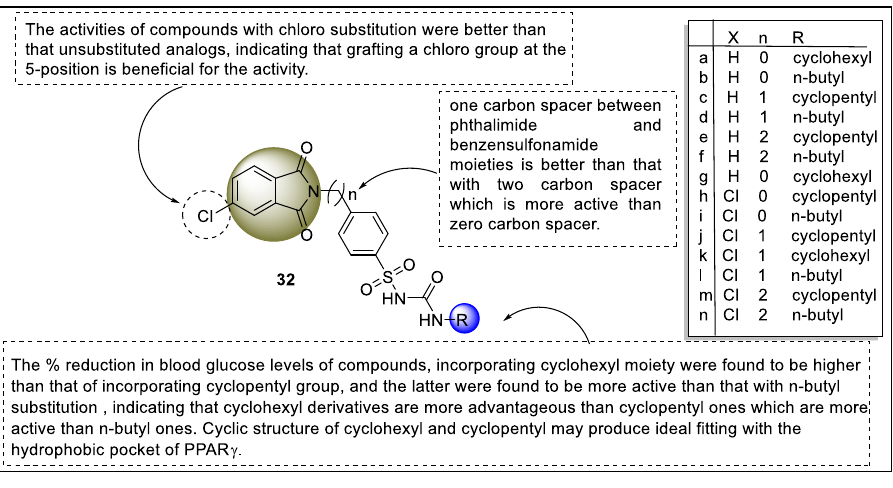
Figure 36. Structural activity relationship of indole hybrids ( 32 ) as potent PPAR